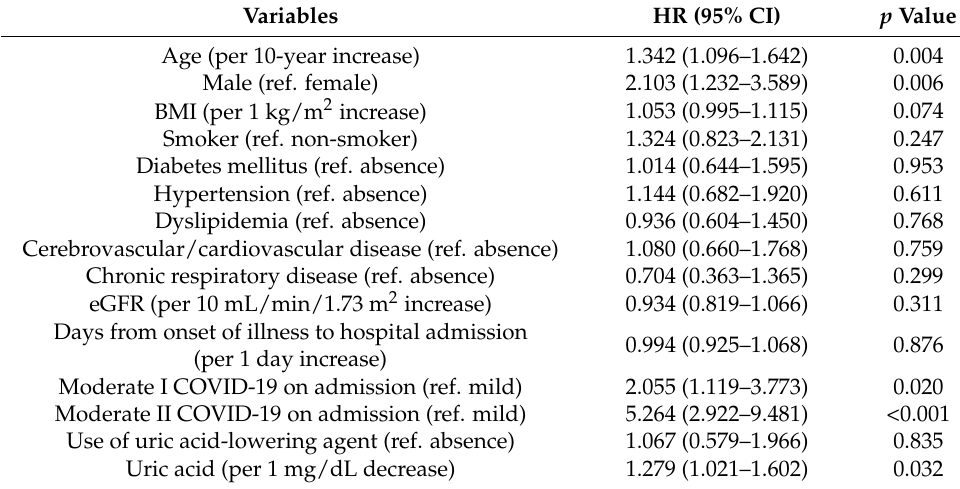
Table 2. Multivariable Cox proportional analysis of factors associated with severe coronavirus disease 2019 (COVID-19) progression.